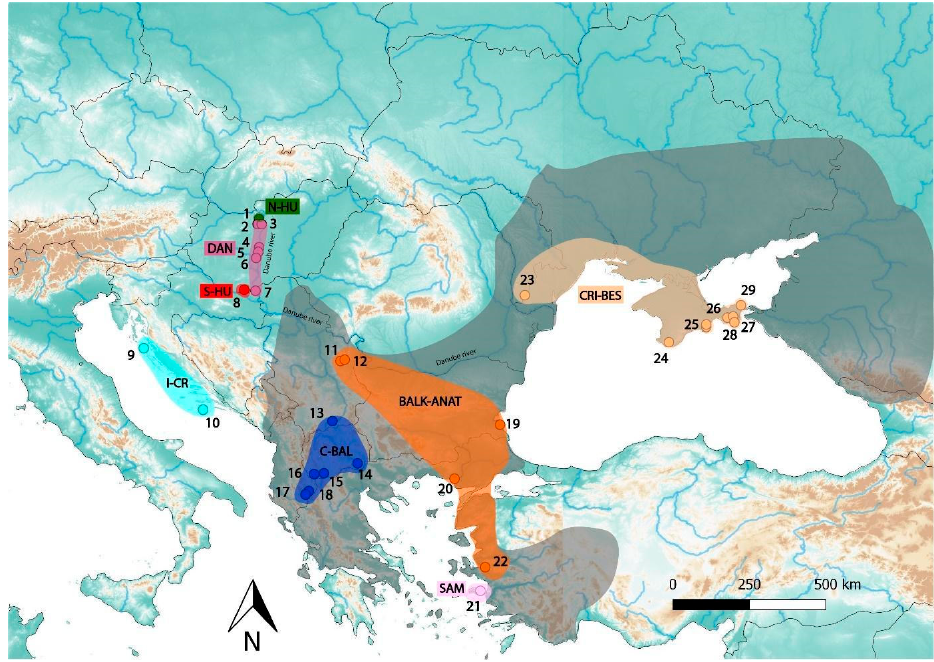
Figure 1. Map of the sampling locations. D. caspius populations are labeled corresponding to Table 1. Di ff erent colors represent eight genetic populations identified by phylogenetic and Principal Component Analysis. The dark shaded area shows the approximate distribution of D. caspius following Sillero et al. [33], slightly modified with the authors’ personal